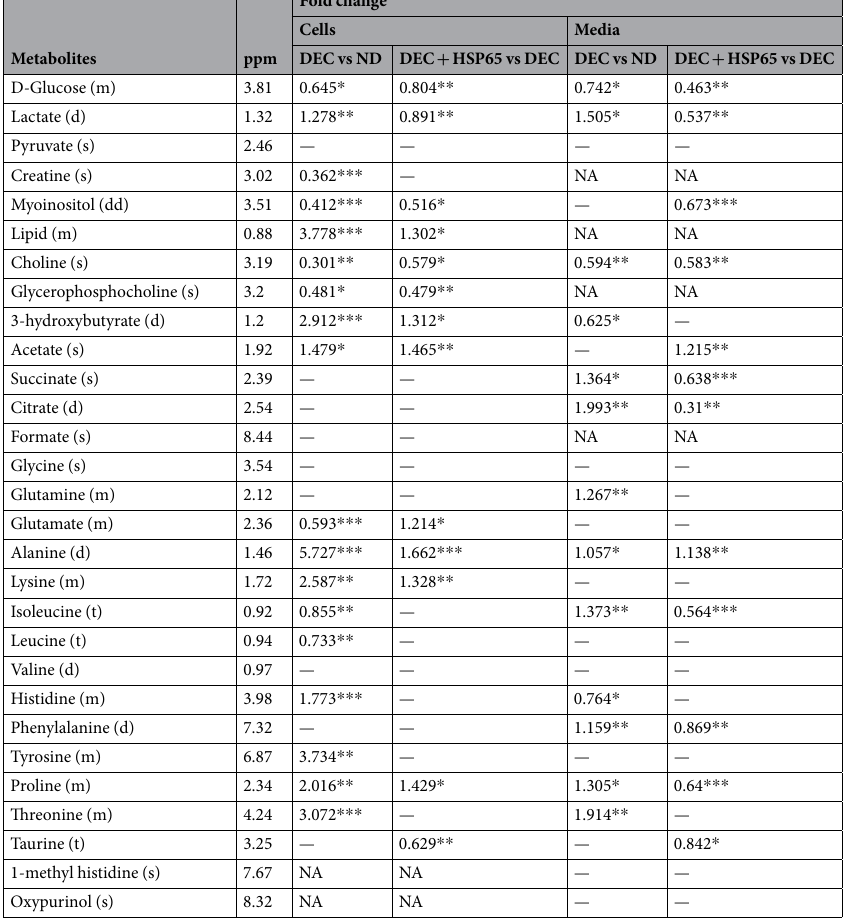
Table 1. Fold change and p-value of intracellular and extracellular metabolites discriminating the